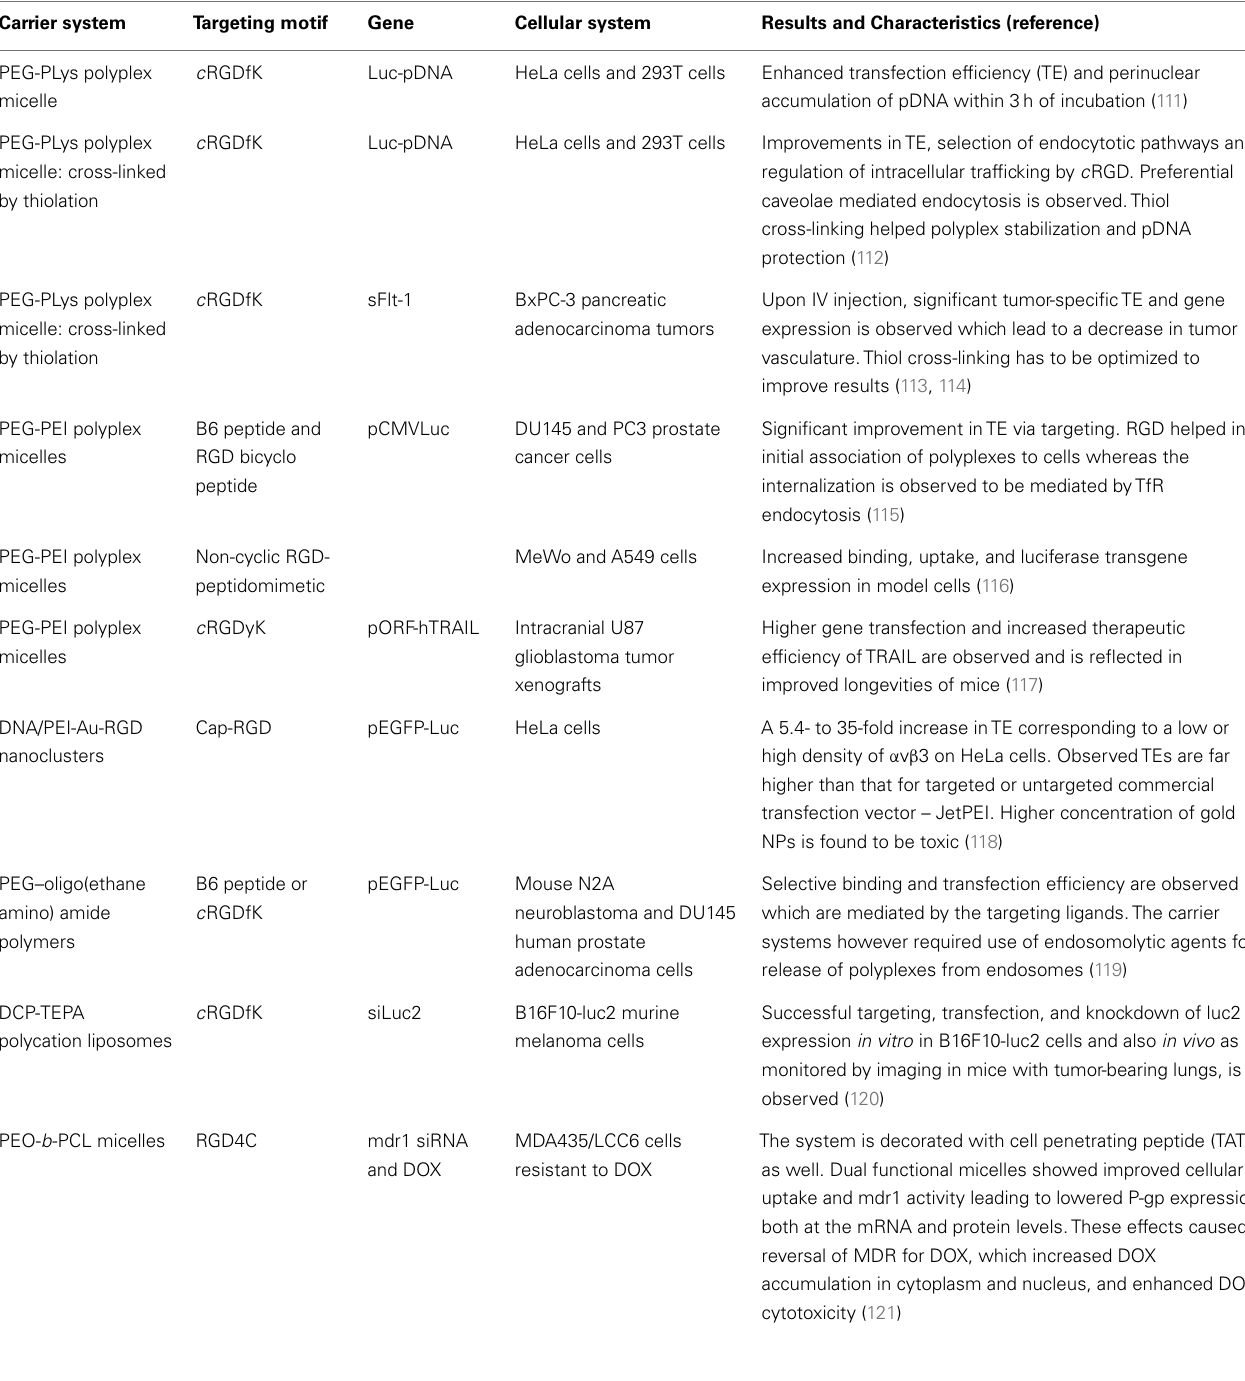
Table 2 | Outline of recent targeted gene delivery studies using α v β 3 and/or α v β 5 integrin